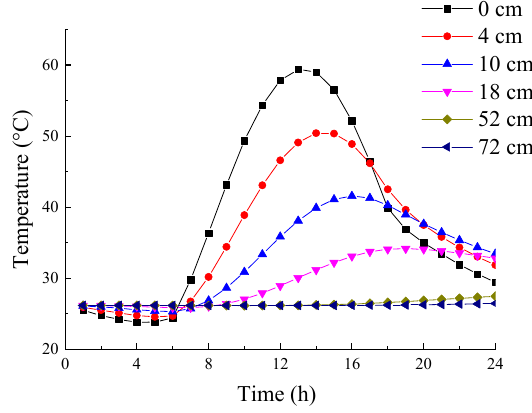
Figure 8. Temperature in each structural layer over 24 h.